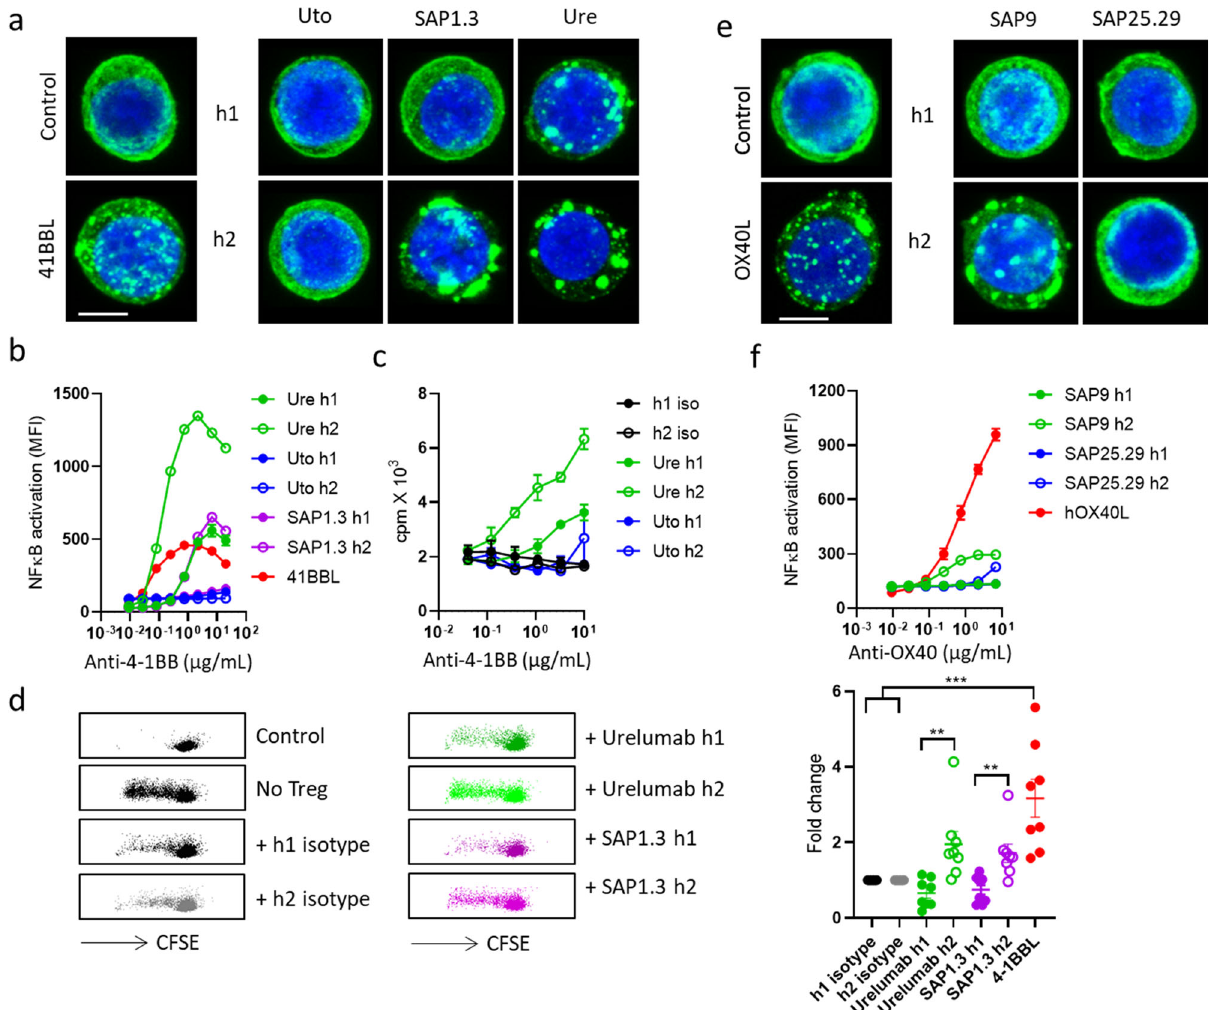
Fig. 5d, while the non-clustering hIgG1 variant of 341G2 did